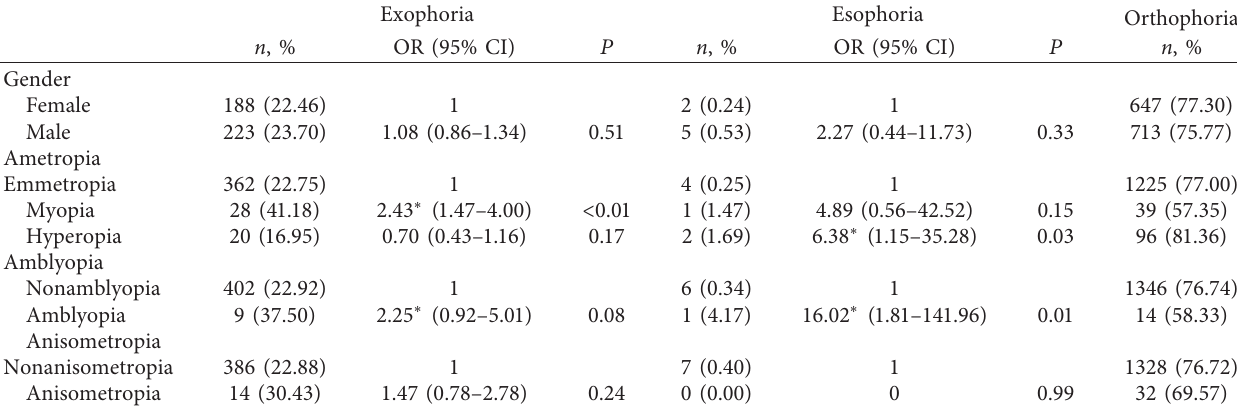
Table 4: Association of heterophoria with gender, amblyopia, ametropia, and anisometropia for grade-one students at near fixation in Lhasa, Tibet Autonomous Region, China.